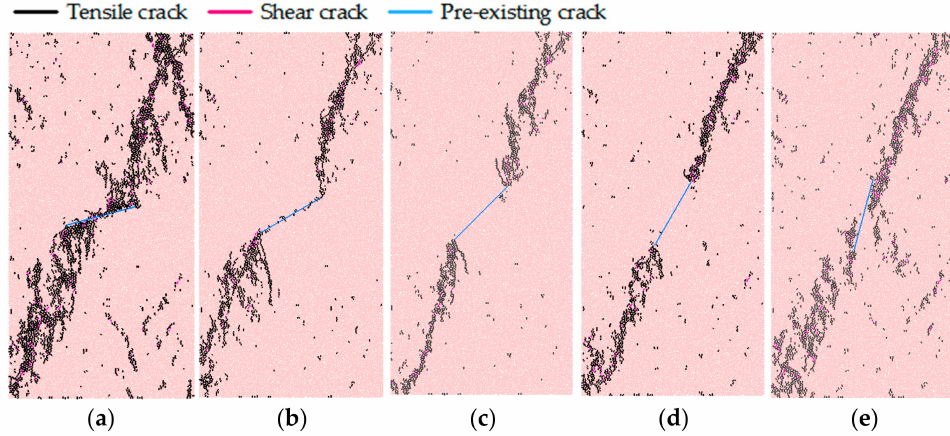
Figure 11. Cracks distribution in the main crack bearing granite with different inclination angles at the moment of peak strength: ( a ) 15 ◦ ; ( b ) 30 ◦ ; ( c ) 45 ◦ ; ( d ) 60 ◦ ; ( e ) 75 ◦